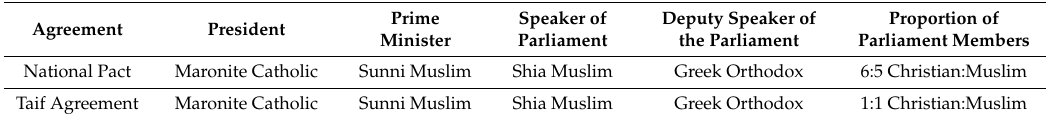
Table 1. Confessional Requirements for Major Political Offices According to the National Pact and Taif